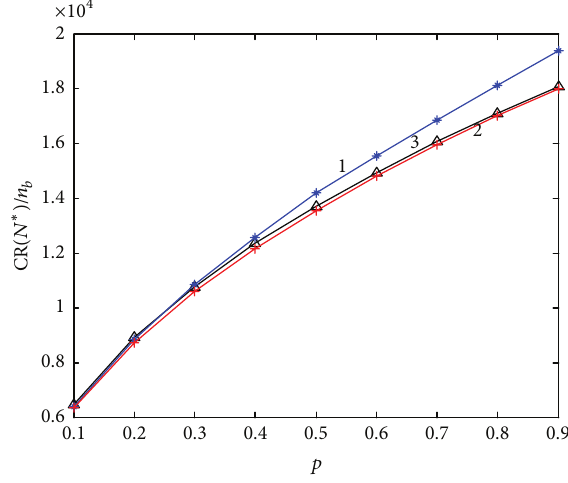
Figure 6: CR (𝑁 ∗ )/𝑛 𝑏 for 𝑝 ∈ {0.1 , 0.2 , .. ., 0.9} and 𝑛 𝑏 ∈ {1, 2, 3}